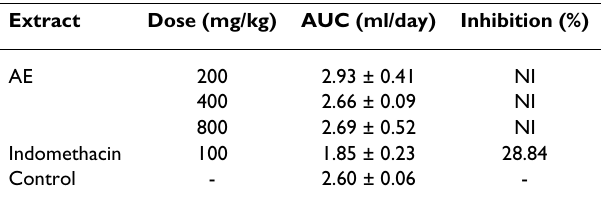
Table 4: Effect of extract on global edematous response to arthritis induced by formaldehyde